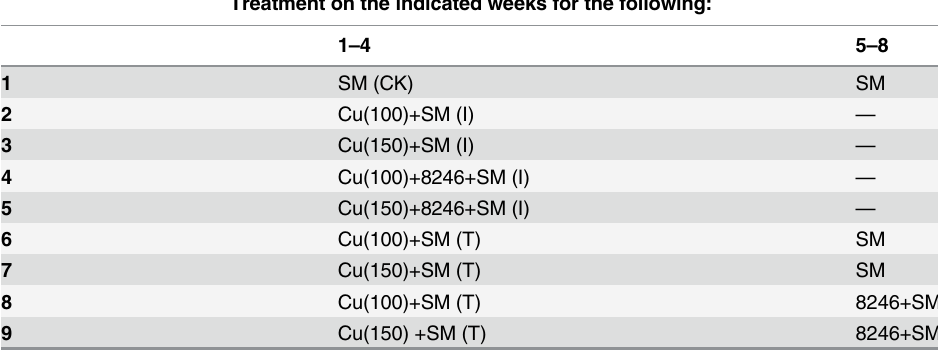
SM, 0.2 mL skimmed milk by gavage ODAT; Cu (100), the concentration of CuSO 4 given once daily by gavage was 100 mg/kg mouse weight; Cu (150), the concentration of CuSO 4 given once daily by gavage was 150 mg/kg mouse weight; 8246+SM, 0.2 mL skimmed milk by gavage ODAT which contains a concentration of 2×10 10 CFU/mL lactobacilli CCFM8246.There are 10 mice in each of 9 groups; CK, the control group; I, the intervention group; T, the therapy